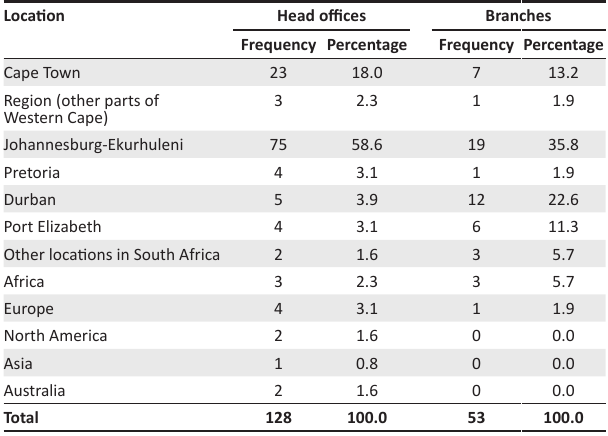
TABLE 3: Location of Cape Town airport-centric development’s head offices and branches. Location